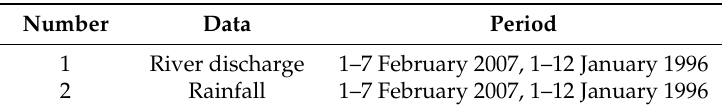
Figure 2. Land-use and soil maps of the Bogor watershed, including: ( a ) land-use in 2009; ( b ) land-use in 2030; and ( c ) the soil map. Table 1. The necessity numerical input data to set up and calibrate the Hydrologic Modeling System (HEC ‐ HMS).